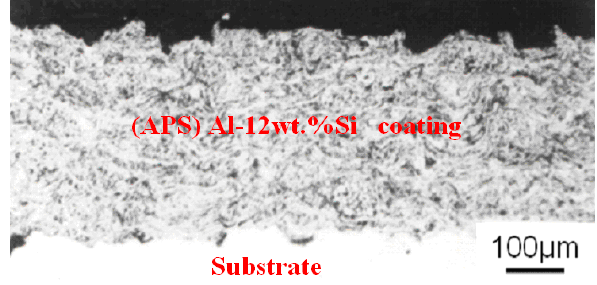
Figure 6: (OM) Etched Al-12Si coating microstructure deposited with powder feed rate of 45 g/min